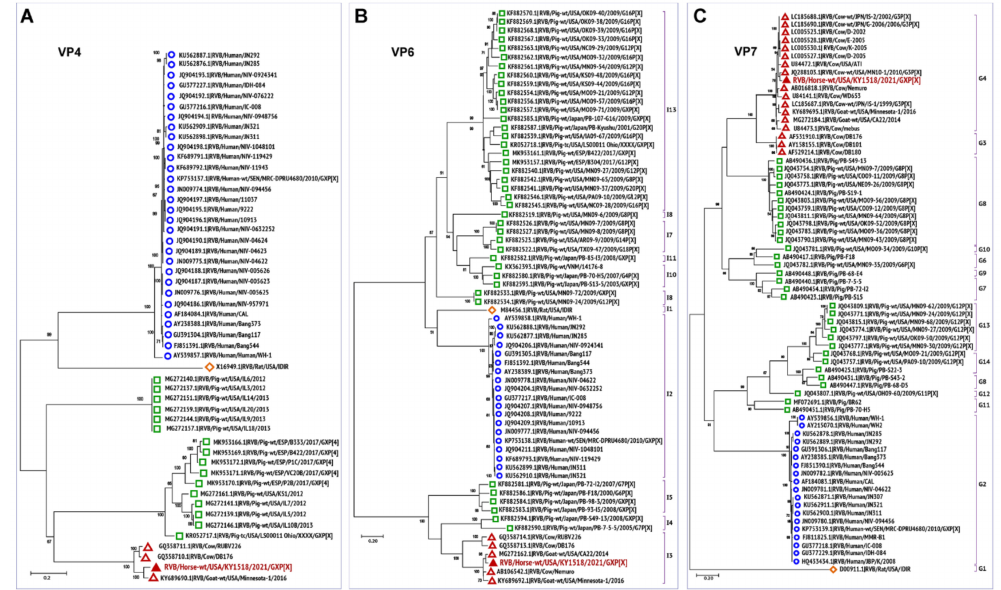
Figure 3. Phylogenetic trees of the complete protein-coding nucleotide sequences of the group B rotavirus VP4 ( A ), VP6 ( B ), and VP7 ( C ) genes. Maximum-likelihood analysis in combination with 1000 bootstrap replicates was used to derive trees based on the nucleotide sequences encoding respective proteins. The RVB strains are color-coded as human (open blue circle), murine (open orange diamond), porcine (open green square), and ruminant (open red triangle), with RVB/Horse- wt/USA/KY/1518/2021 (filled red triangle) highlighted in red font. The genotypes of RVB strains associated with VP6 and VP7 segments are also shown. The RVB VP6 (I) genotypes were based on the proposed 81% nucleotide and 89% amino acid identity cut-off values. The known VP7 (G) genotypes from G1–14 associated with RVB strains are also shown [27,45]. The distantly related porcine RVB strains of G15–23 genotypes were not included in the VP7 phylogenetic analyses. A scale representing evolutionary distance indicates the number of nucleotide substitutions per site is also shown in each panel. Bootstrap values are shown above branches to the left of major